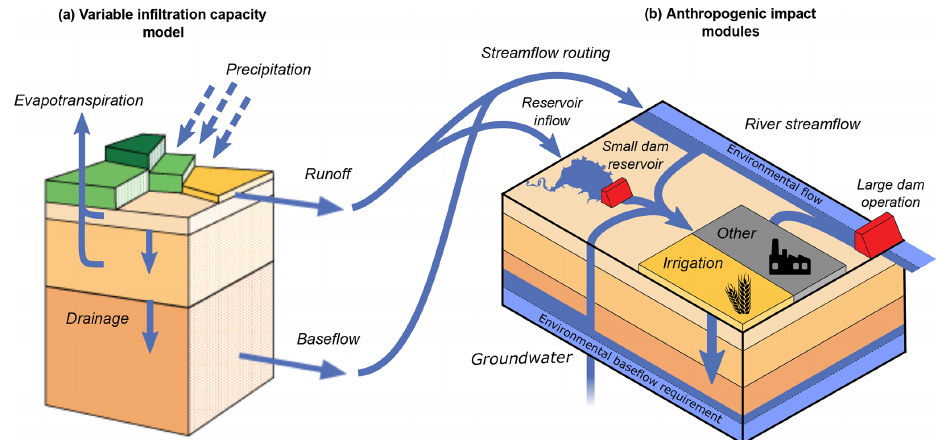
Figure 1. Schematic overview of the VIC-WUR model that includes the VIC-5 model (a) and several anthropogenic impact modules (b) . Water from river streamflow, groundwater, and small (within-grid) reservoirs is available for withdrawal. Surface and groundwater with- drawals are constrained by environmental flow requirements. Withdrawn water is available for irrigation, domestic, industrial, energy, and livestock use. Unconsumed irrigation water is returned to the soil column of the hydrological model. Unconsumed water for the other sectors is returned to the river streamflow. Small reservoirs fill using surface runoff from the cell that they are located in, whereas large dam reservoirs operate solely on rivers’